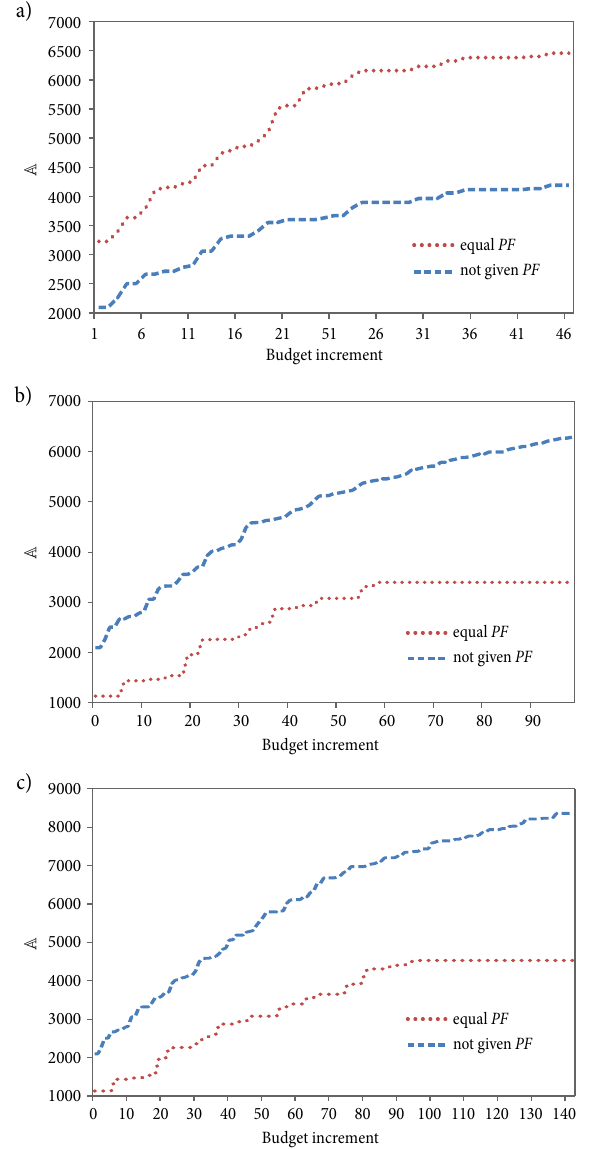
Fig. 6. Absolute capacity versus budget increment: